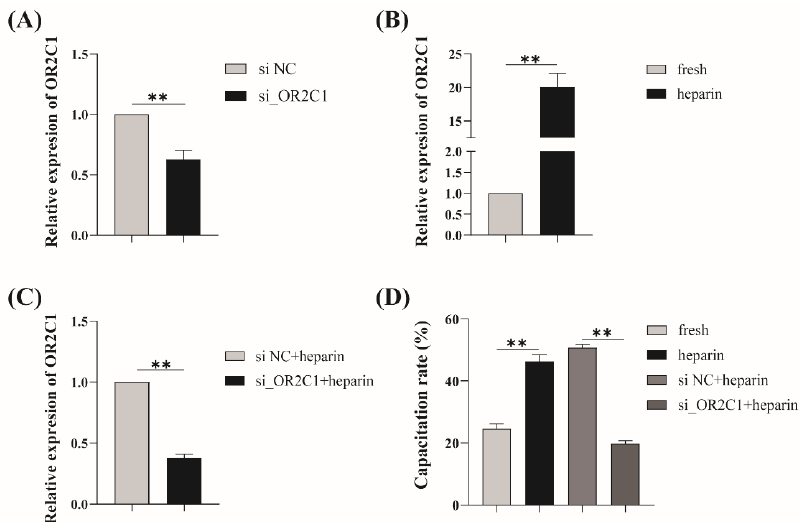
Figure 6. Histograms of relative mRNA expression of OR2C1 and sperm capacitation rate with si- OR2C1 . ( A ) The relative mRNA expression of OR2C1 in si_ OR2C1 and ( B ) treated with heparin group; ( D ) the sperm capacitation rate of si_ OR2C1 and further treated with heparin group. The Y -axis displays the relative expression of the OR2C1 gene ( A – C ) and sperm capacitation rate (%, D ), respectively. Non-targeting siRNA oligonucleotides were transfected as negative control (si NC). ** p < 0.01. The data are representative of at least three independent experiments (mean ± SEM).